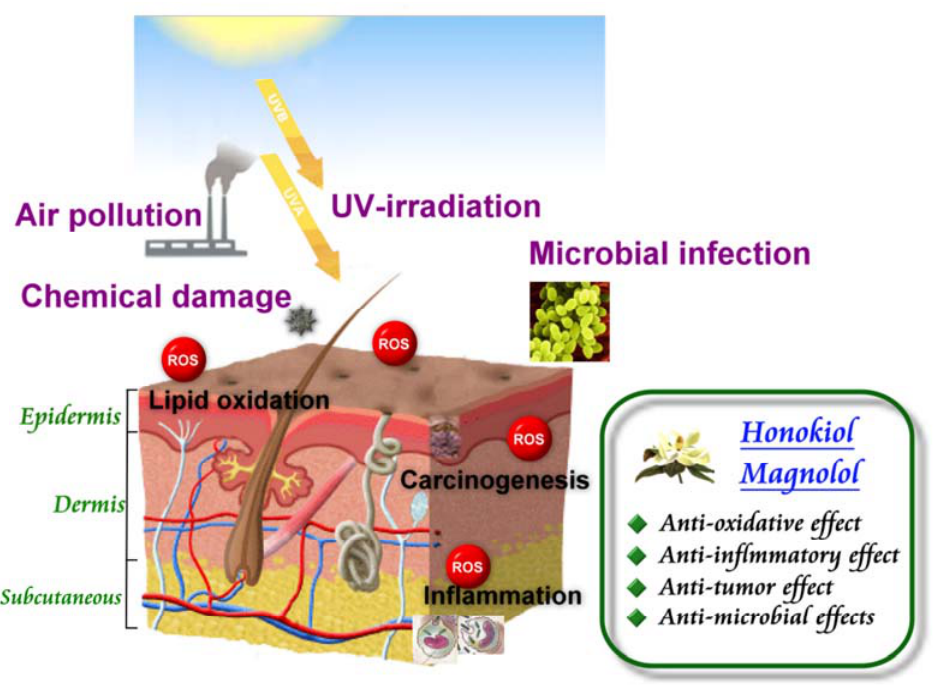
Figure 3. The protective effects of honokiol/magnolol for dermatologic